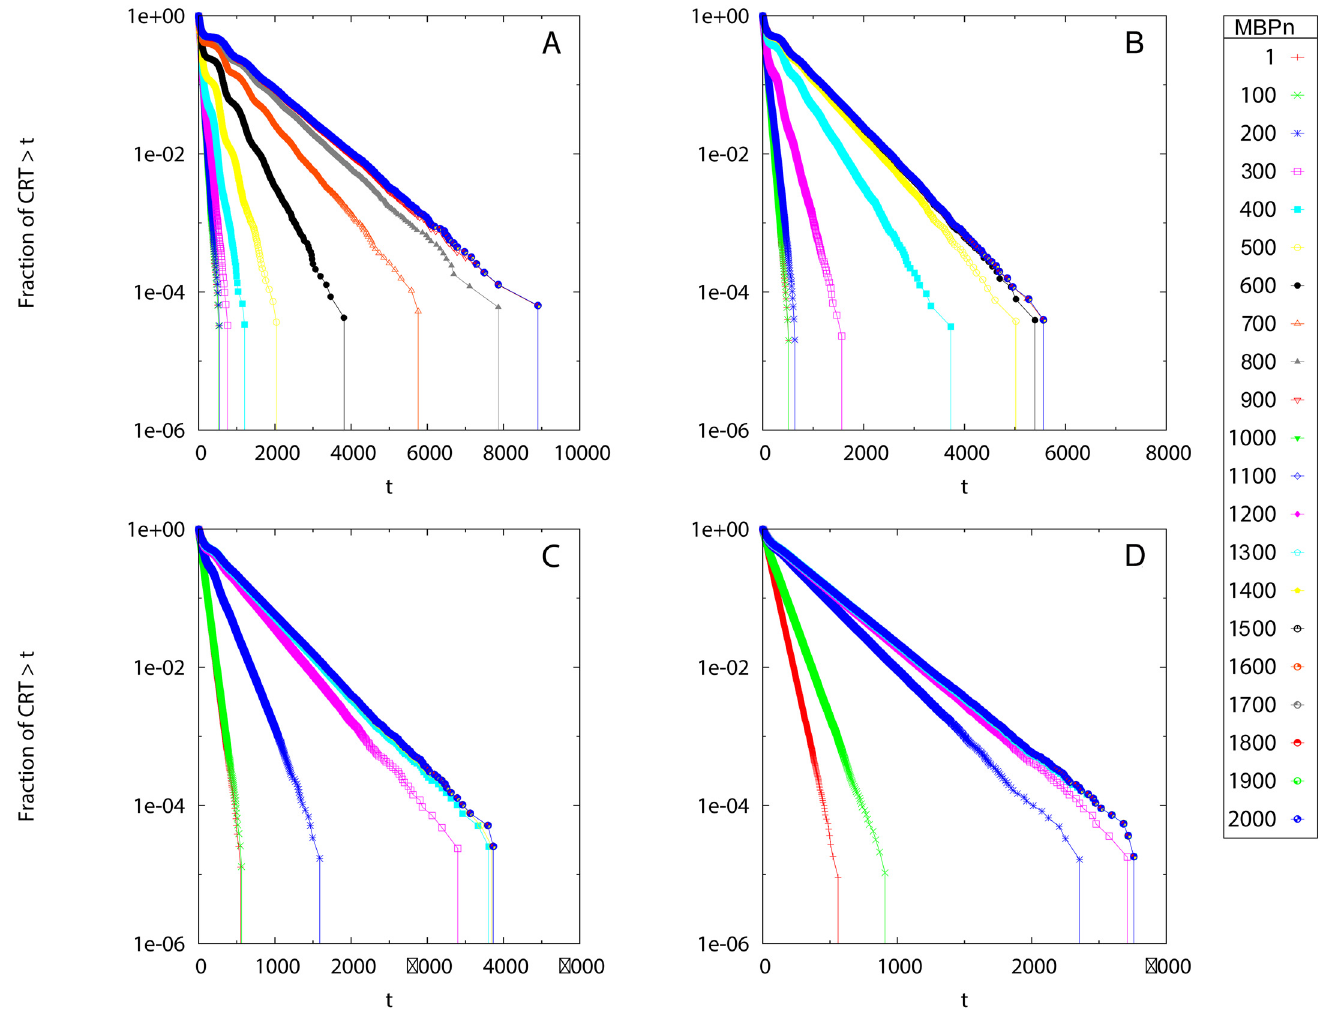
Fig 3. Scenario 2: Survival curves of CRTs. The survival curves are obtained for different values of MBP n (see legend) and different model parameters in Eq (4): γ = 0.01 (A), 0.02 (B), 0.04 (C) and 0.08 (D). The y axis is in logarithmic scale.